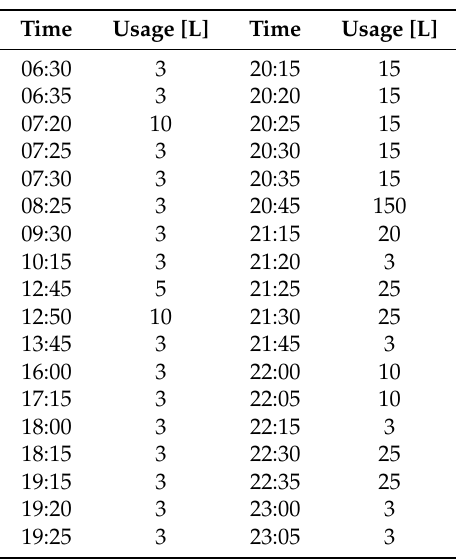
Table 4. Hot water usage. Reproduced from [32], publisher: